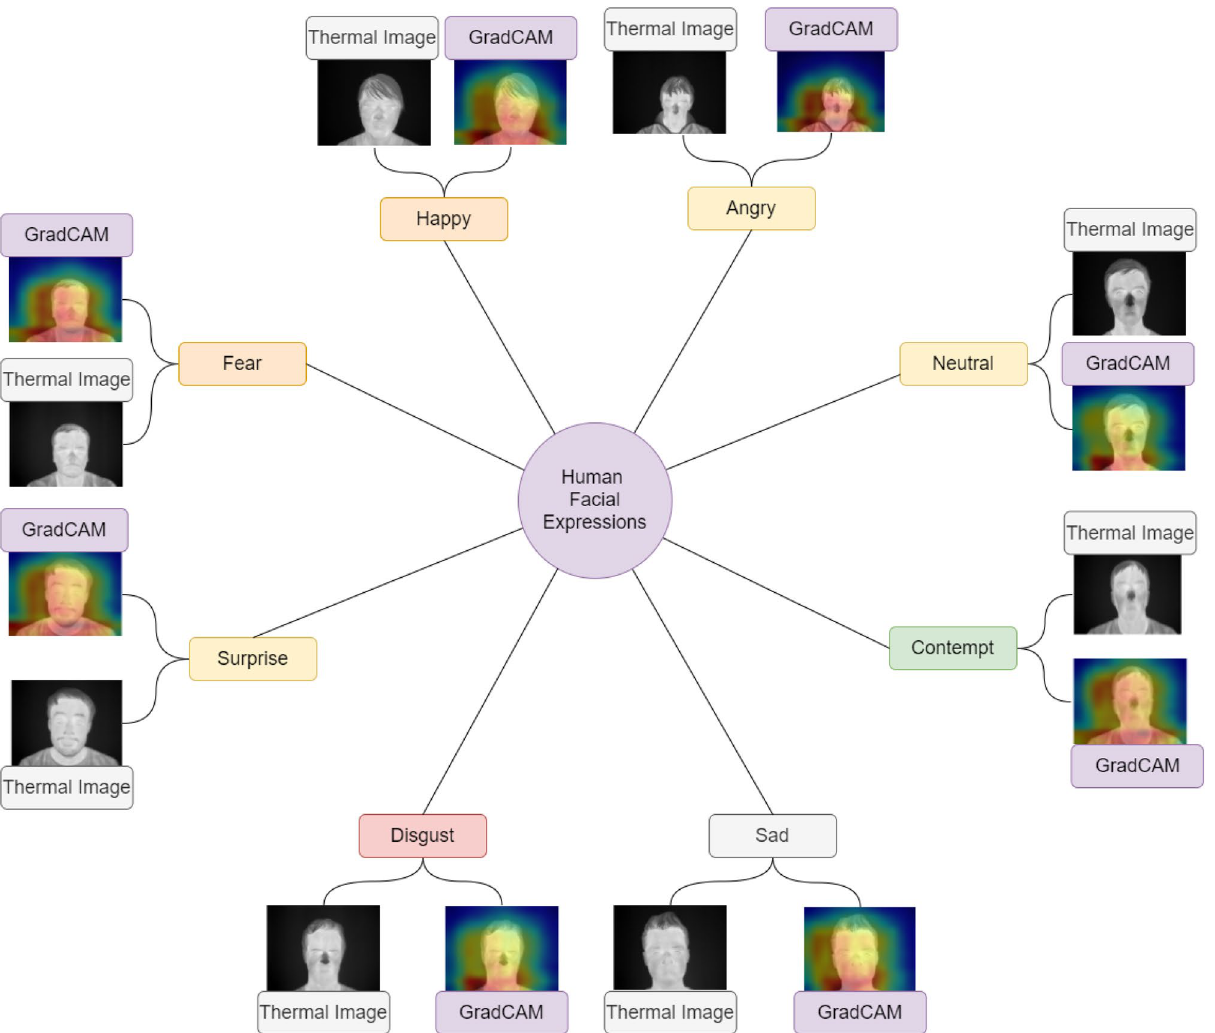
Figure 11. Grad-CAM output on IRFacExNet for IR images having different expressions. Image is developed using Draw.io 32